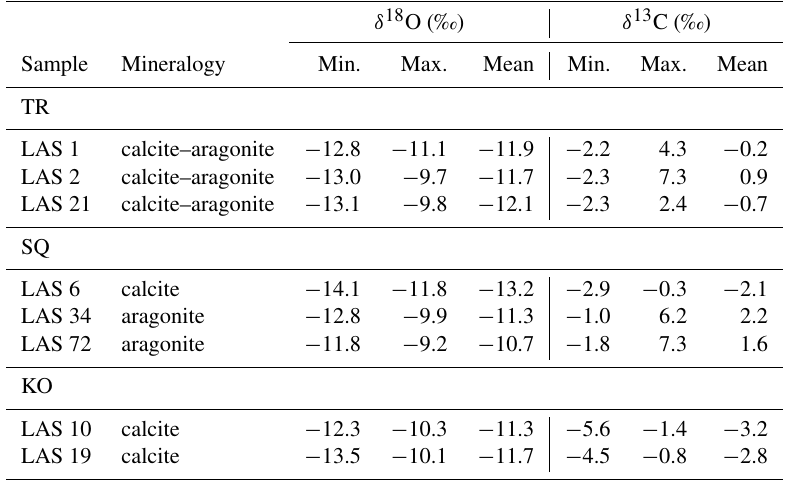
LAS 6 calcite LAS 34